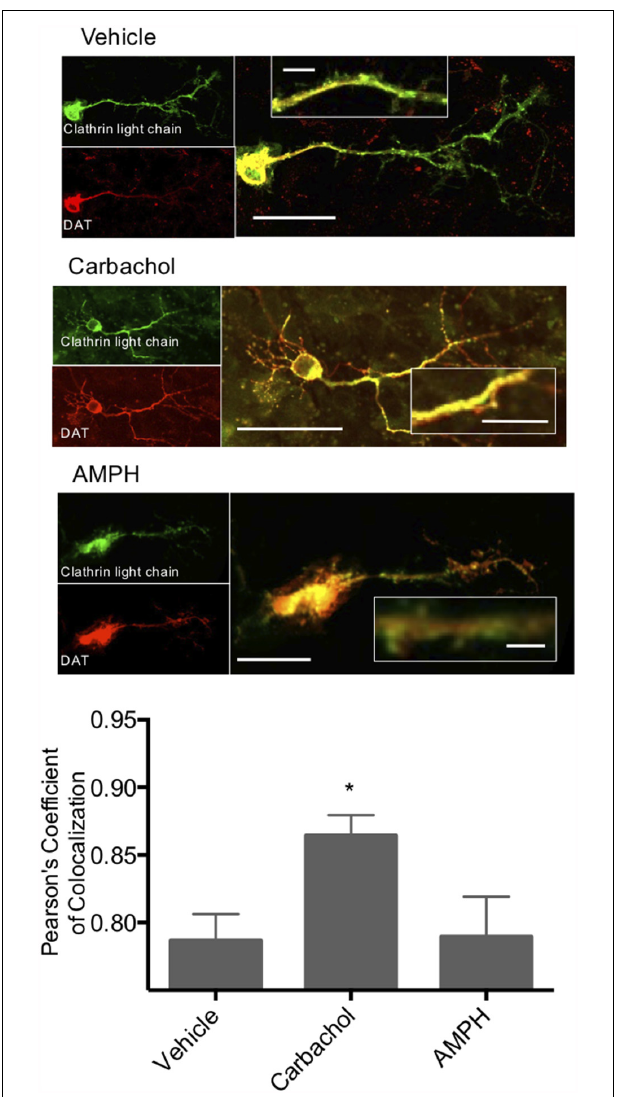
FIGURE 5 | Clathrin and DAT colocalize in response to carbachol. Primary midbrain neurons were transfected with a GFP-tagged clathrin light chain and an mCherry-tagged DAT. Colocalization of these two proteins was significantly increased in response to carbachol treatment (30 µ M). Treatment of the cultures with amphetamine did not alter co-localization. *Indicates p < 0.05 by one-way ANOVA. n = 19, 15, and 12, respectively. Scale bars = 50 µ m for merged images, 10 µ m for the insets.